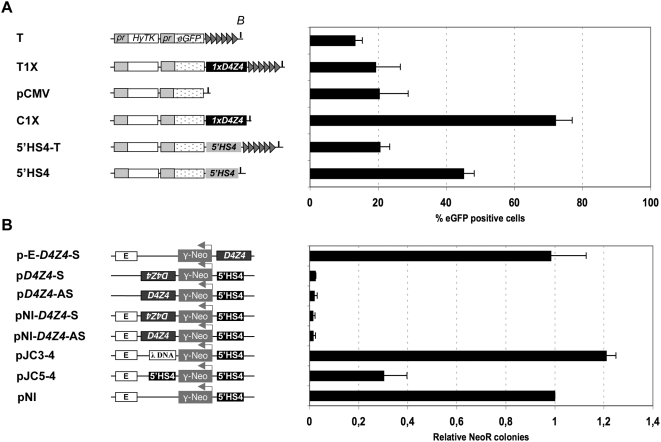
A single D4Z4 acts as a boundary that interferes with position effect and enhancer-promoter communication.A. The different constructs carry a hygromycin resistance gene fused to the herpes simplex virus type 1 thymidine kinase suicide gene (HyTK, white box) and an eGFP reporter gene (speckled box), each driven by a CMV promoter (pr). In the T construct, a telomere seed (grey triangles) is added downstream of the eGFP reporter gene in order to create a de novo telomere after random integration followed by a telomeric fragmentation [47]. A single D4Z4 repeat (black box) is cloned downstream of the eGFP gene in pCMV construct (C1X) or between eGFP and the telomere seed in T construct (T1X). We further compared D4Z4 with the canonical chicken 5′ HS4 boundary [19] by cloning this latest sequence into the vectors used for de novo telomere seeding (5′HS4-T) or for random integration (5′HS4). Each constructs were linearized and transfected into the human cervical carcinoma cells (C33A). The level of eGFP was measured by flow cytometry (FACS) for an extended period of time in the presence or absence of Hygromycin B (Figure S1A). Histograms show the average percentage of eGFP positive cells from day 18 to day 29 of three independent transfections ±S.D. shown by error bars, when eGFP expression reaches a plateau (Figure S1B). The integrity of each construct was verified in stable populations of cells (Figure S1D). B. In order to evaluate the enhancer blocking activity of D4Z4, we used the test previously described [19]. The K562 human erythroleukemia cell line was stably transfected with the constructs shown on the left. Each construct carries the neomycin resistance gene driven by the human A β-globin promoter (γ-Neo) flanked with the mouse 5′HS2 enhancer (E). Most constructs contain the 5′HS4 insulator upstream of the promoter in order to block from the influence of regulatory elements at the site of integration. For each assay, colony number was normalized to the un-insulated control (pNI). Data are the average of three independent transfections. The mean values with S.D. are plotted. As controls, the following constructs, kindly provided by Dr. G. Felsenfeld, were used: pNI, no insert; pJC3-4, 2.3 kb of λ DNA; pJC5-4, chicken β-globin 1.2 kb 5′HS4 insulator [19].